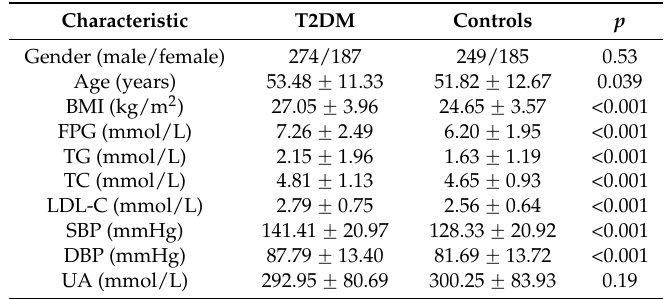
Table 1. Demographic information and clinical characteristics of the participants. Characteristic